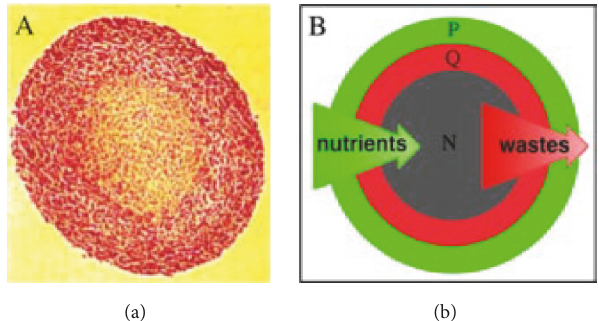
Figure 1: Structure of a typical tumor spheroid: a proliferating layer in the outer rim and an inner core of necrotic cells, separated by a layer of quiescent